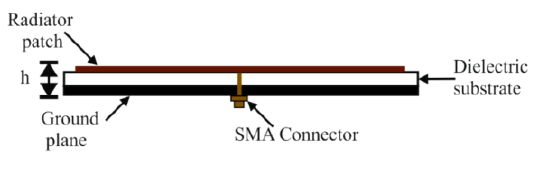
Figure 1. Enhanced performance of aeronautical Radar service using a steerable